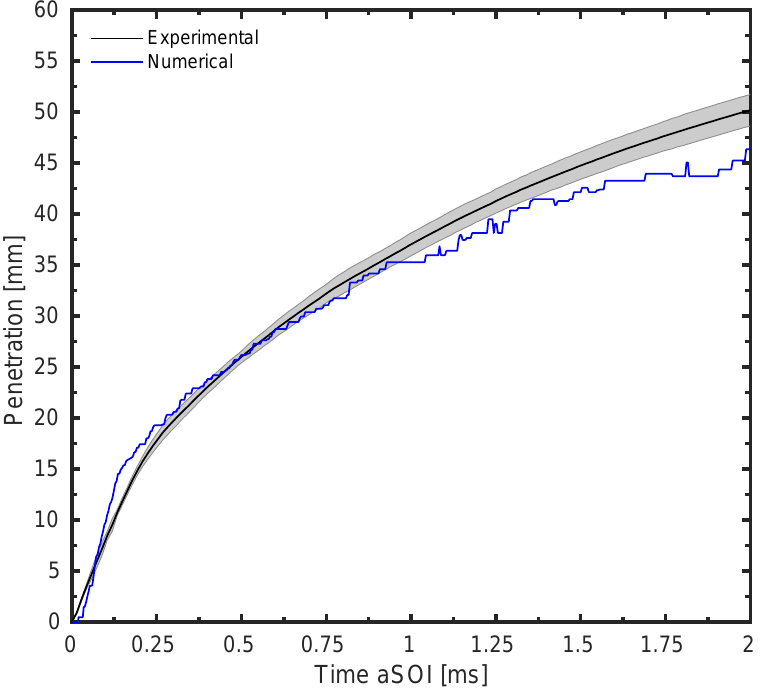
Figure 5. Numerical and experimental axial vapor phase penetration for the baseline condition